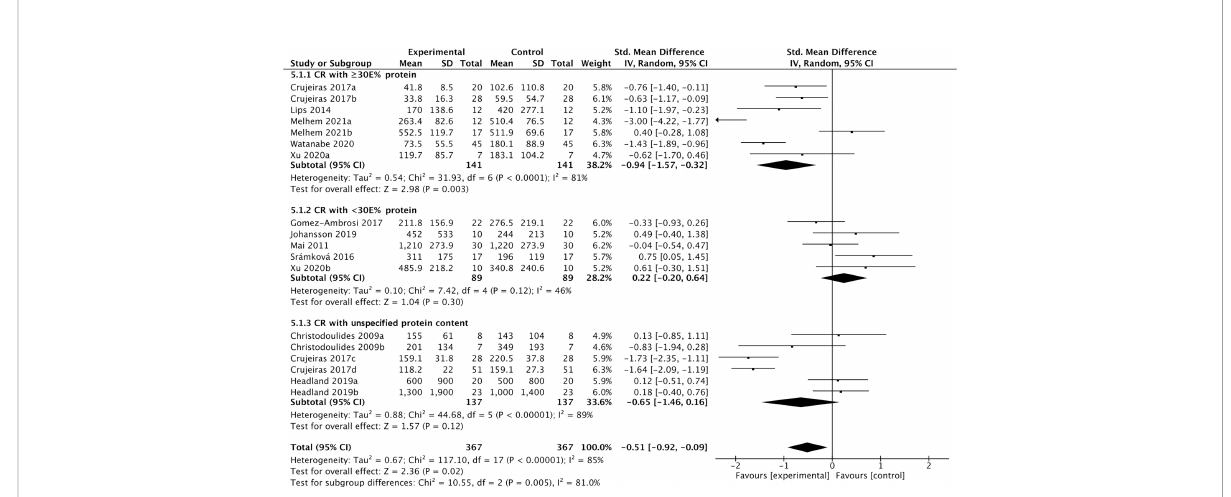
FIGURE 5 Forest plot of cFGF21 concentration in individuals before and after calorie restriction-induced weight loss. Random effect models were used as the pooling method. The mean value refers to the mean cFGF21 concentration in each group. cFGF21, circulating fi broblast growth factor 21.